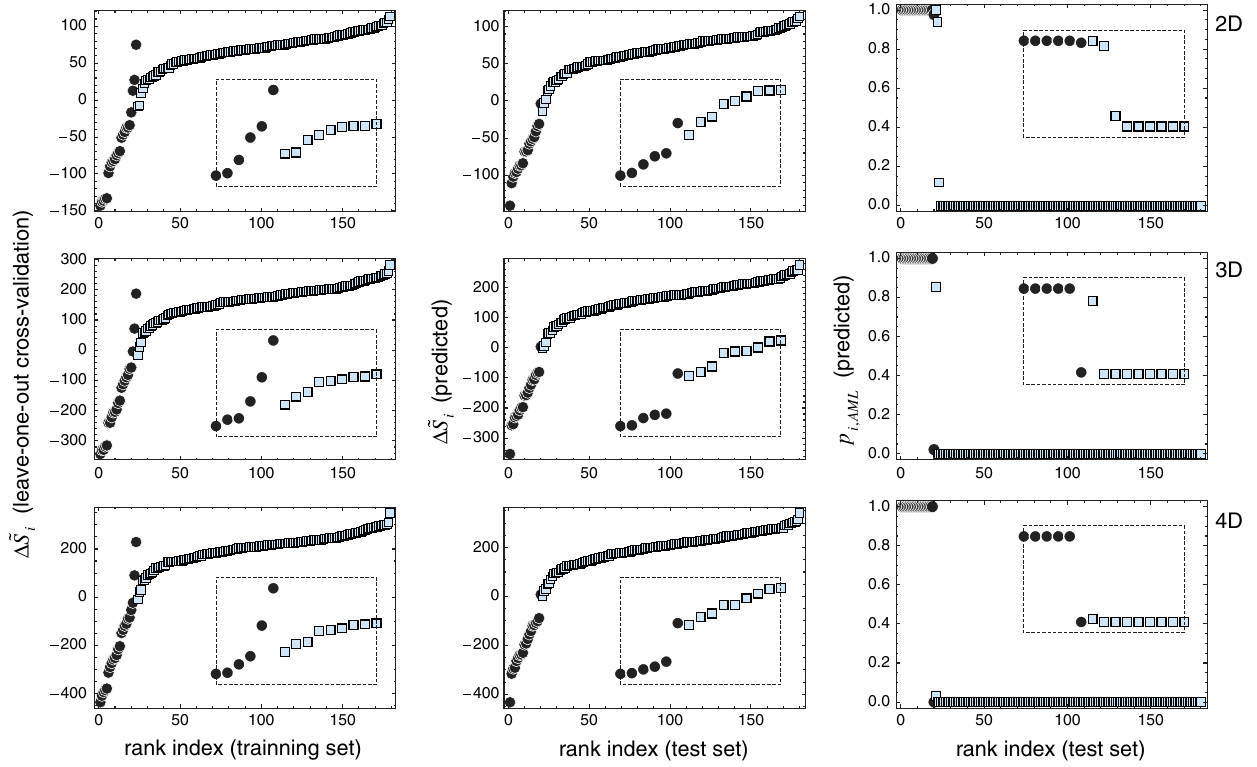
FIG. 2. Entropy-based discrimination between AML and normal individuals. The total relative entropy difference, using Eq. (5) with w 1 , is shown for each individual of the training and test sets for two-, three-, and four-dimensional landscapes. The likelihood that k ¼ an individual of the test set is AML positive, given by Eq. (6), is also shown for two-, three-, and four-dimensional landscapes. Circles and squares represent, respectively, the actual AML and normal state of a patient as clinically assessed by a physician. The insets are magnifications around the AML-normal